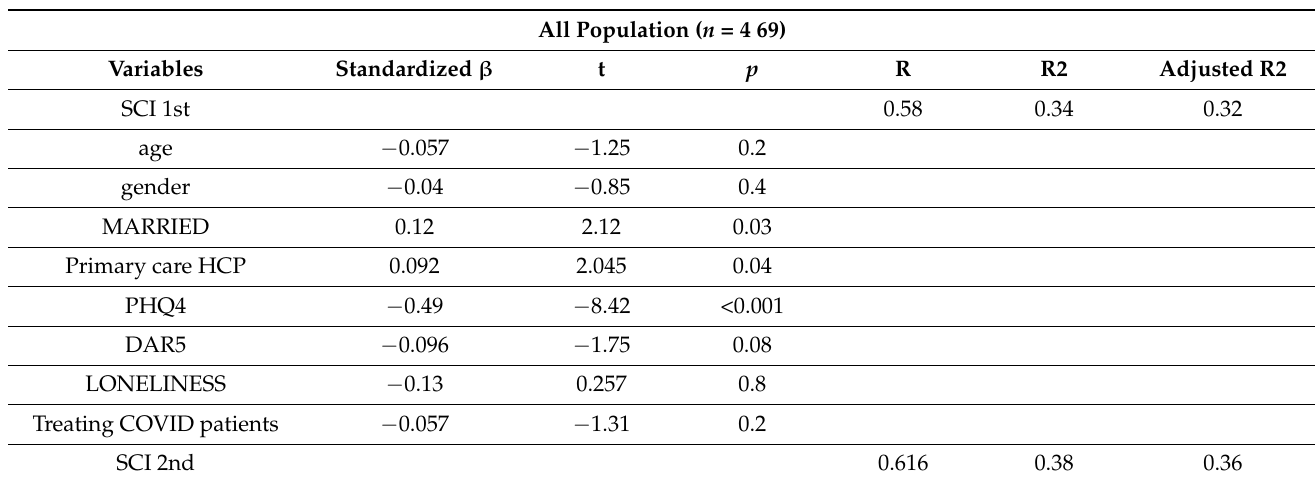
Table 5. Multiple regression analysis examining the association between sleep quality and character- istics of the population of HCPs and separately of primary care HCPs followed during the 1st and the 2nd